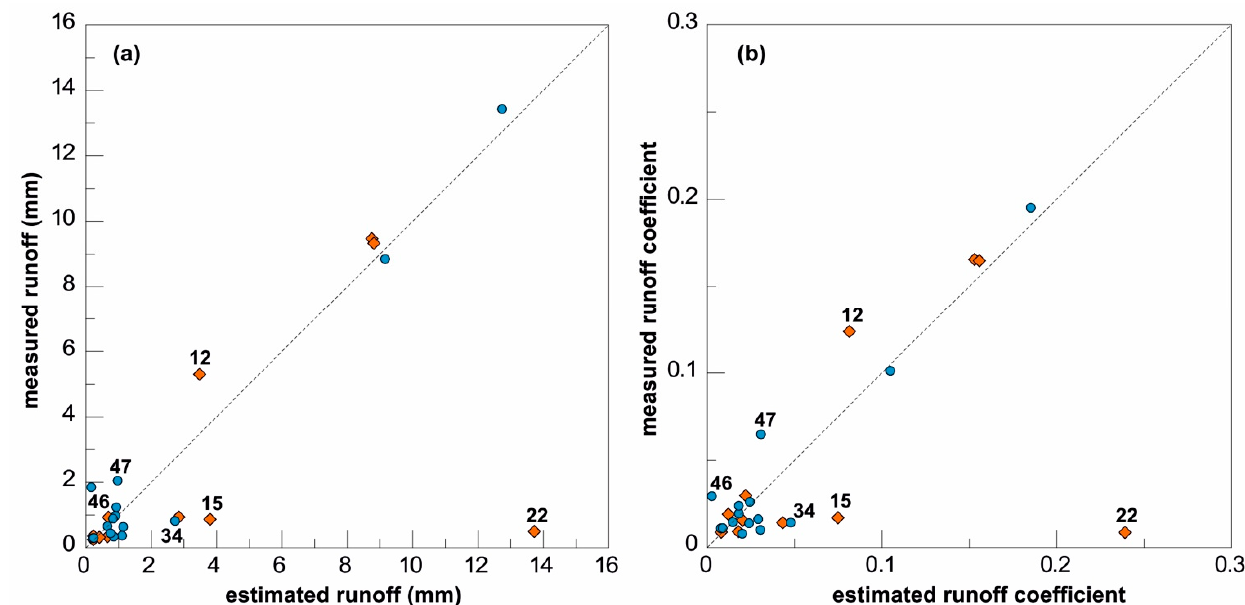
Figure 3. Comparison between the measured runoff and the runoff estimated by the models Q = f (ADSI + P), Equations (7a,b) and (8a,b) ( a ); same comparison based on the runoff coefficient ( b ). Blue dots and orange diamonds indicate autumn–winter and spring–summer events, respectively. The numbers associated with some selected events referred to in Table S1.